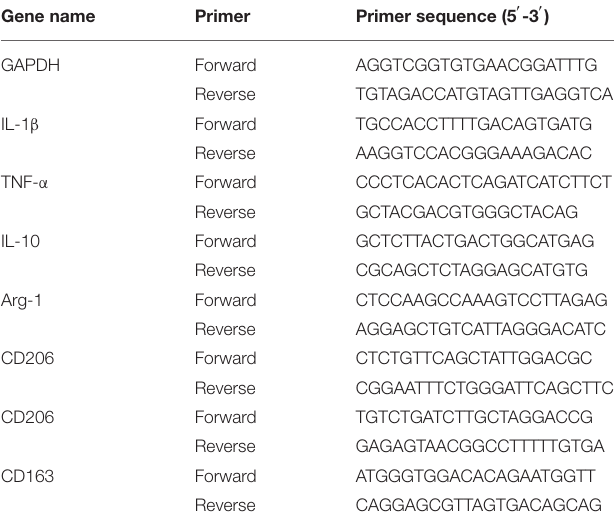
TABLE 1 | Primers used for quantification of targeted genes in Quantitative real-time